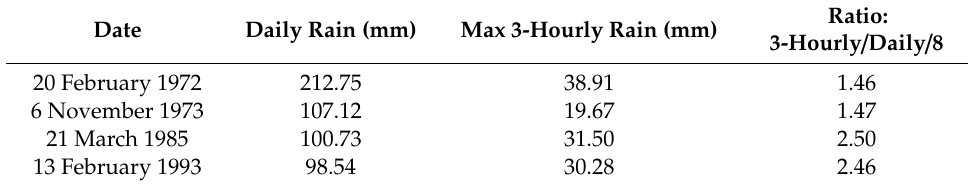
Table 1. Recorded daily rain events (mm), maximum 3-hourly measured rain (mm) and the ratio of 3-hourly rain data to daily data divided with 8 three-hours per day through the EC-